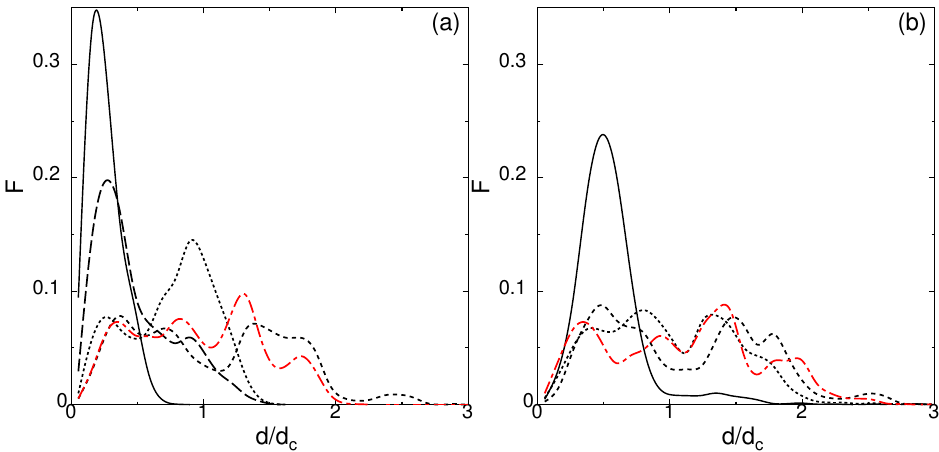
Figure 8. Self-van Hove correlation function of state O at ( a ) T = 88 for different time durations t = 11,000–19,000 (solid), 15,000–19,000 (dotted), 17,000–19,000 (dashed), 18,000–19,000 (long dashed), and 20,000–21,000 (red dot–dashed); ( b ) T = 116 for time t=16,700–19,700 (solid), 17,700–19,700 (dot- ted), 18,700–19,700 (dashed) and 20,000–21,000 (red dot–dashed), for system size N =